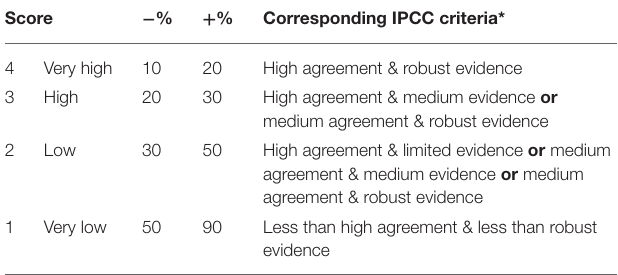
TABLE 3 | “Score” for evaluating the quality of time series of reconstructed catches, with their confidence intervals (IPCC criteria from Figure 1 of Mastrandrea et al., 2010) †